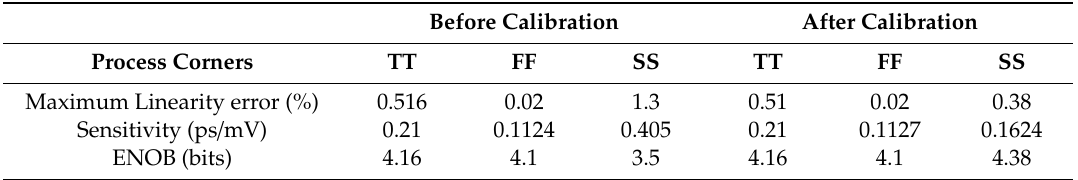
Table 3. Performance of the first proposed VTC at process corners before and after calibration. Before Calibration After Calibration Process